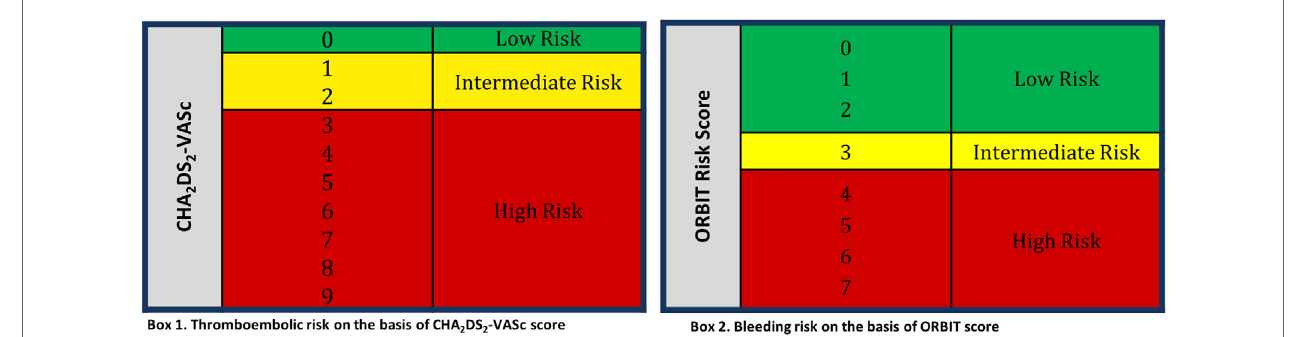
FiGUre 5 | Study design flowchart. Schematic representation of patients’ selection and randomization.